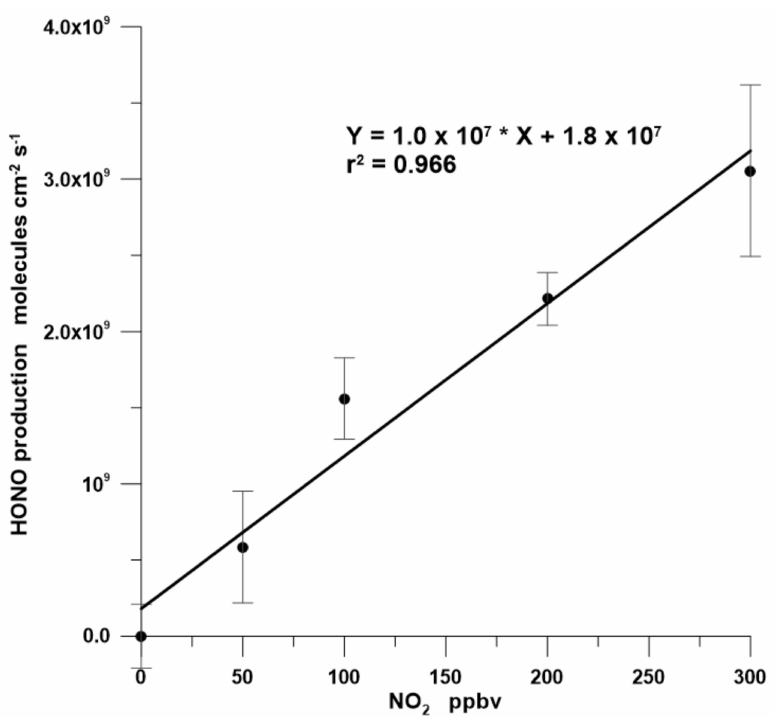
Figure 3. HONO production rates as functions of NO 2 concentrations. Mixing ratios of toluene and total ultraviolet (TUV) were fixed as 500 ppbv and 11.3 Wm − 2 ,